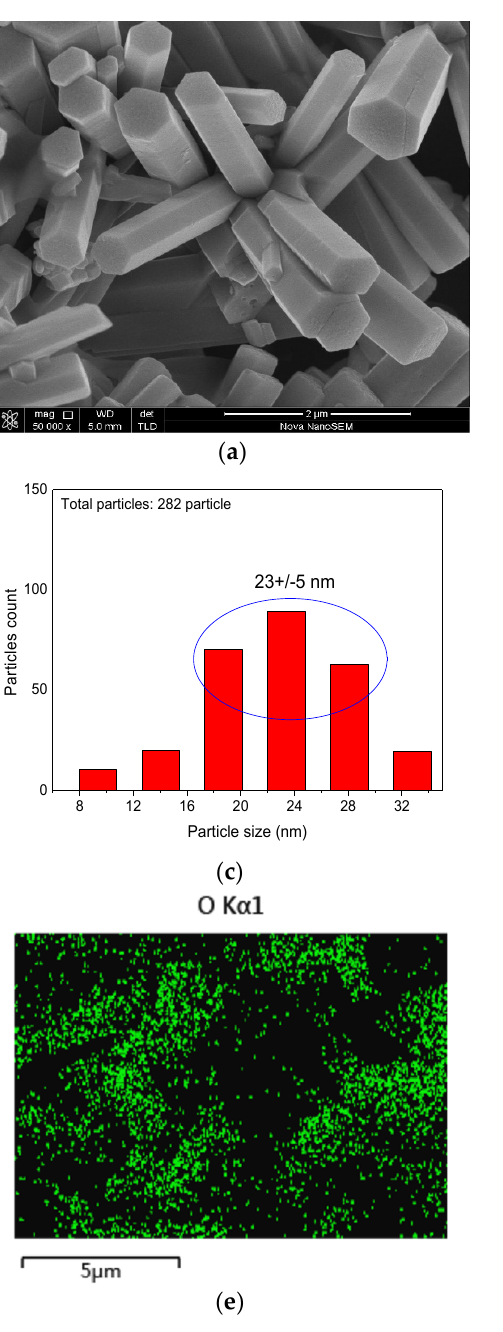
Figure 1. Scanning electron microscopy (SEM) imaging of ZnO and ZnO/Cu x=1.25 O samples: ( a ) image of the hexagonal ZnO nanowires in a 2 micron scale, ( b ) image of the ZnO/Cu x=1.25 O showing the Cu x O NPs, and ( c ) size distribution of Cu x O NPs using imageJ. The mapping by electron dispersive spectroscopy (EDX) shows the atomic distribution of ( d ) Zn, ( e ) O and ( f ) Cu.